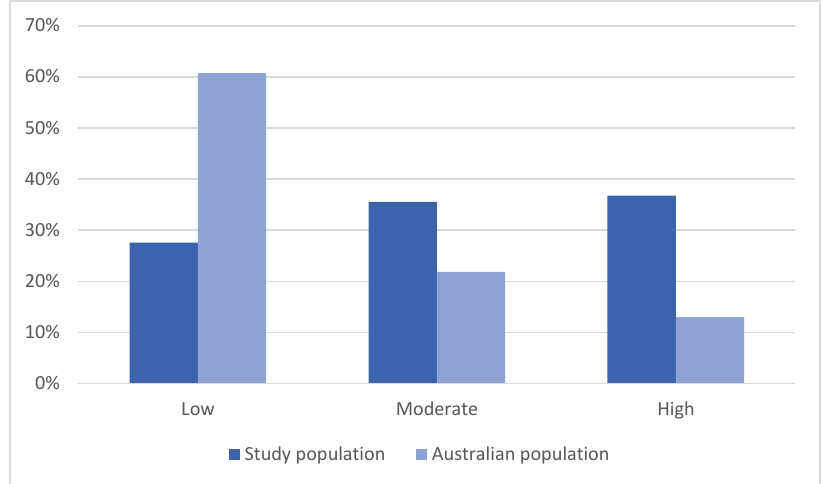
Figure 3. Comparison of levels of psychological distress between the study and Australian populations [34].